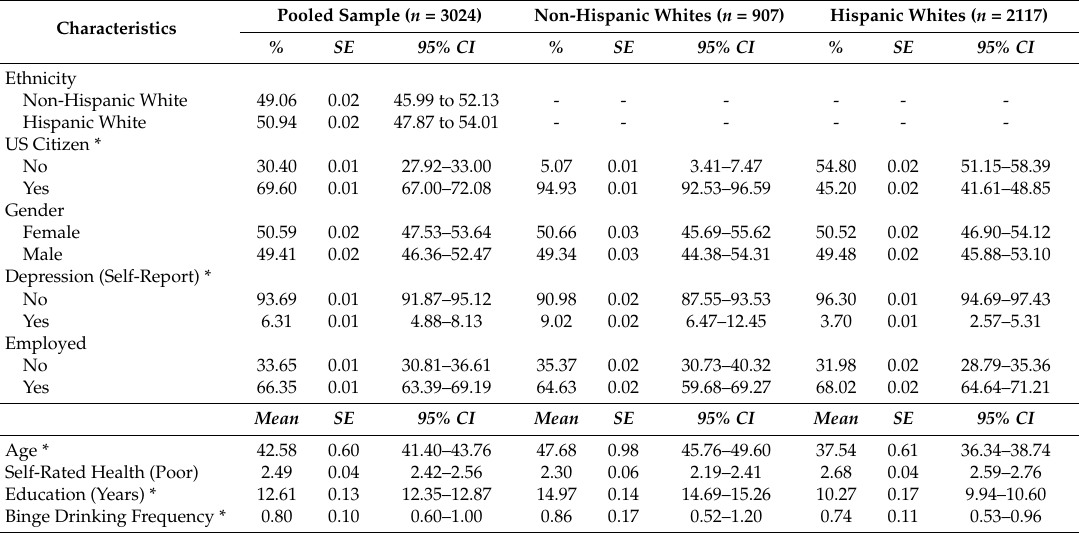
Table 1. Descriptive statistics in the pooled sample and by